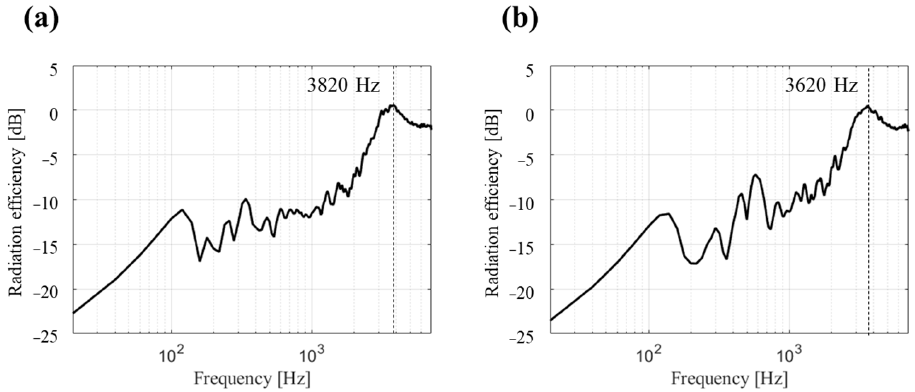
Figure 18. Radiation efficiency: ( a ) front windshield; ( b ) side